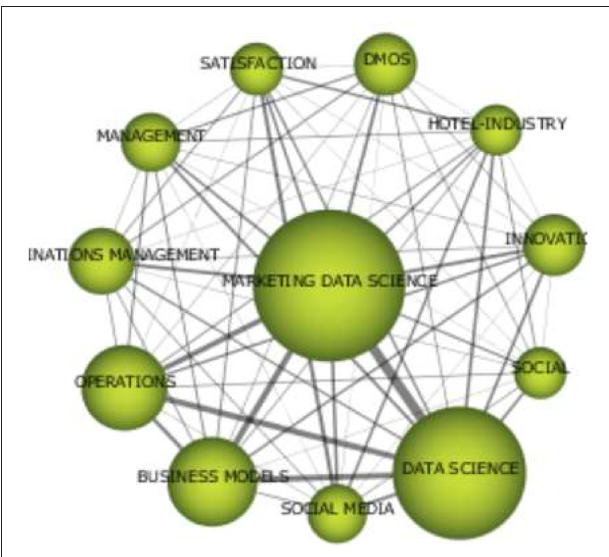
FIGURE 9 | Strategy analysis of publications/thematic evolution (1995–2021). Source: prepared by the authors based on SciMAT.